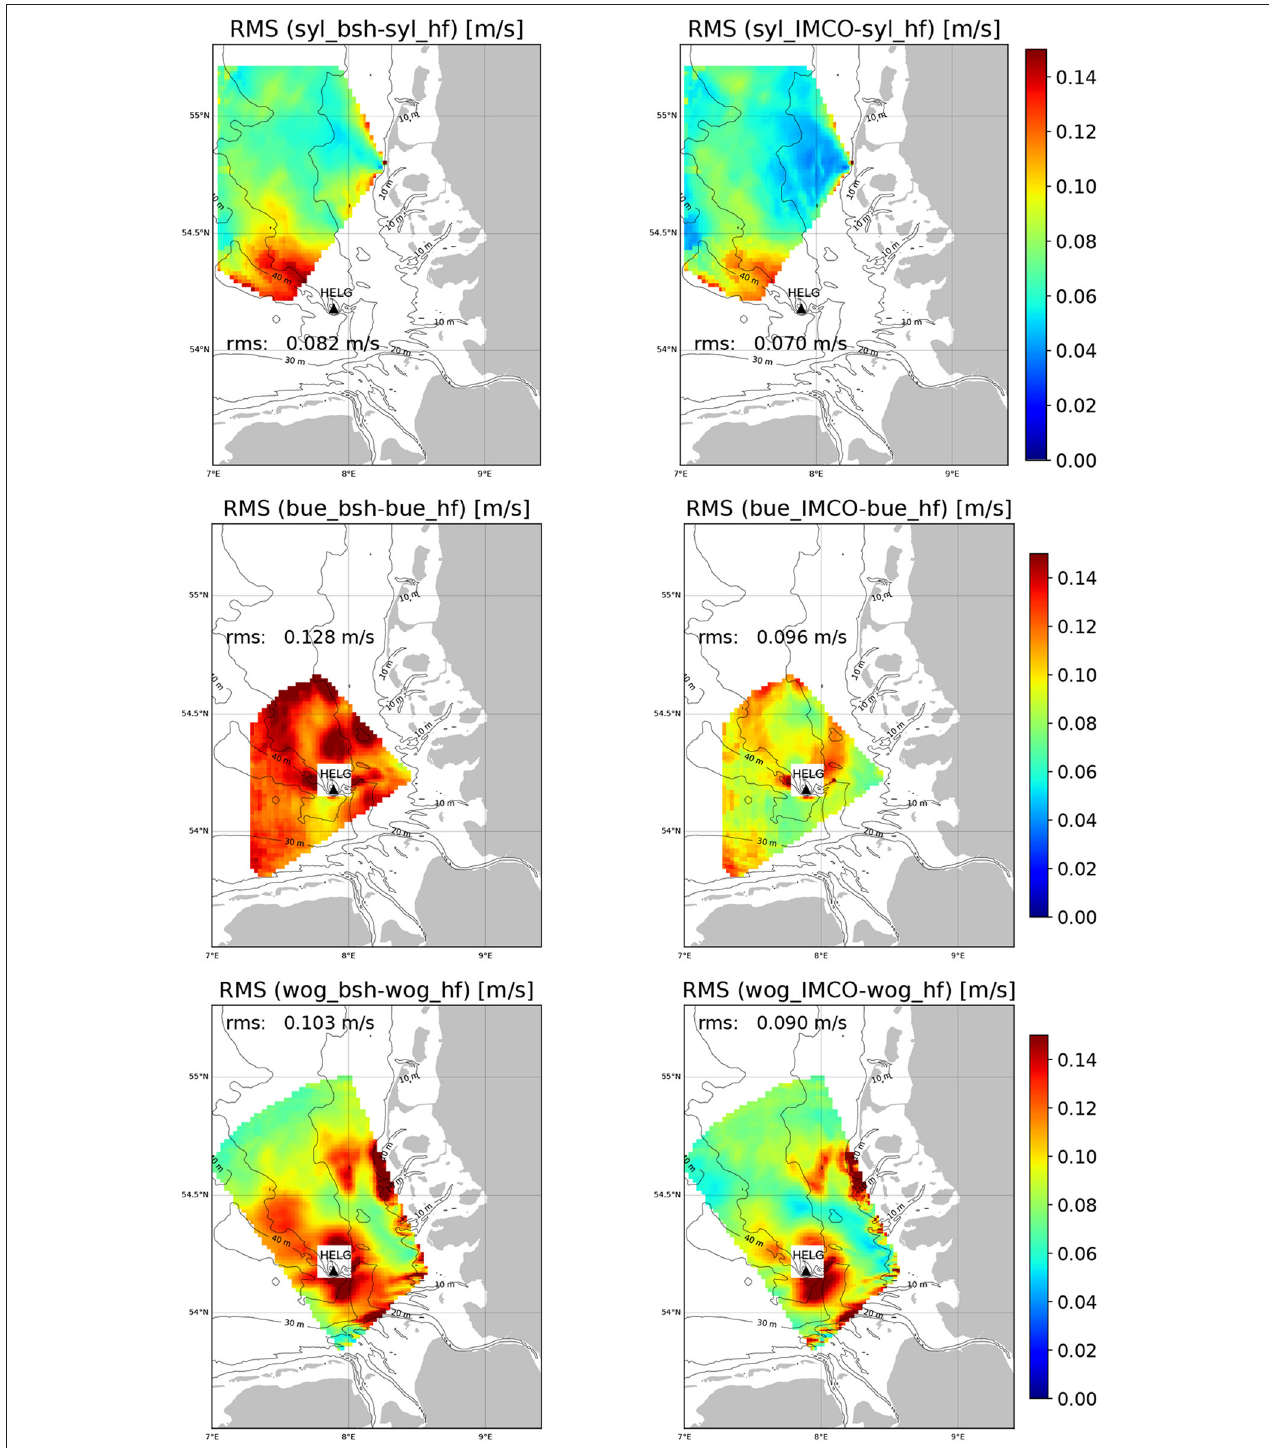
FIGURE 6 | Comparison of tuned 4DVAR results and BSH model data with HFR measurements for the radial components acquired by the Sylt (top) , Büsum (middle) , and Wangerooge stations (bottom) . The RMS values refer to the period May 15–May 29, 2015. The black triangle marks the position of the island Helgoland. due to processes, which are of a more stochastic nature, in particular the metereological forcing and density